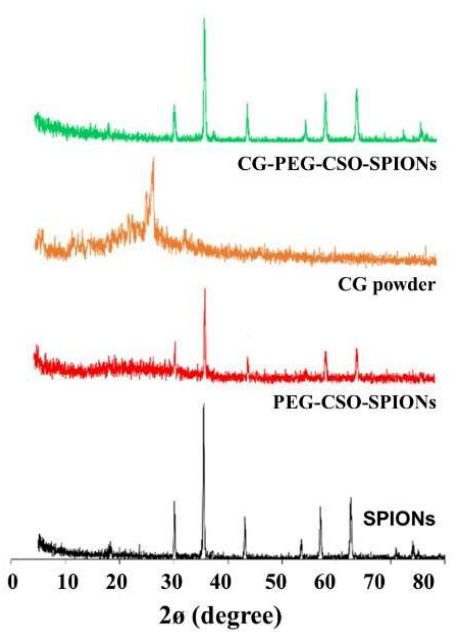
Figure 6. Representative XRD patterns of SPIONs, PEG-CSO-SPIONs; CG powder, and CG-PEG-CSO-SPIONs.